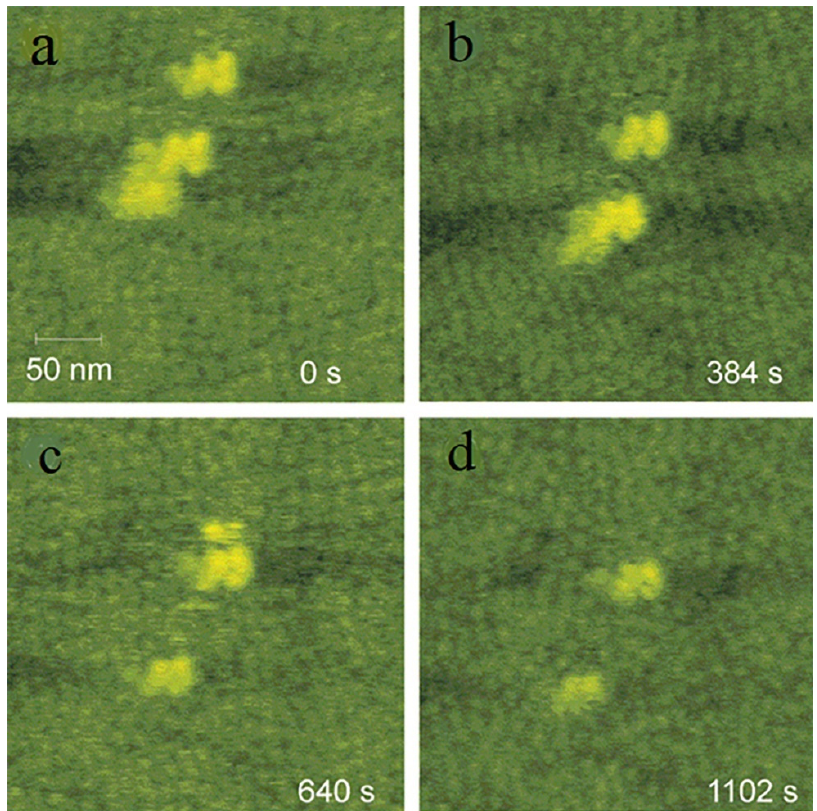
Figure 2. AFM image of clusters evolution in protein solution with C = 0.23 mg mL − 1 and σ = 2.3. ( a ) 0 s, ( b ) 384 s, ( c ) 640 s, ( d ) 1102 s. C as the actual protein concentration and σ as the supersaturation